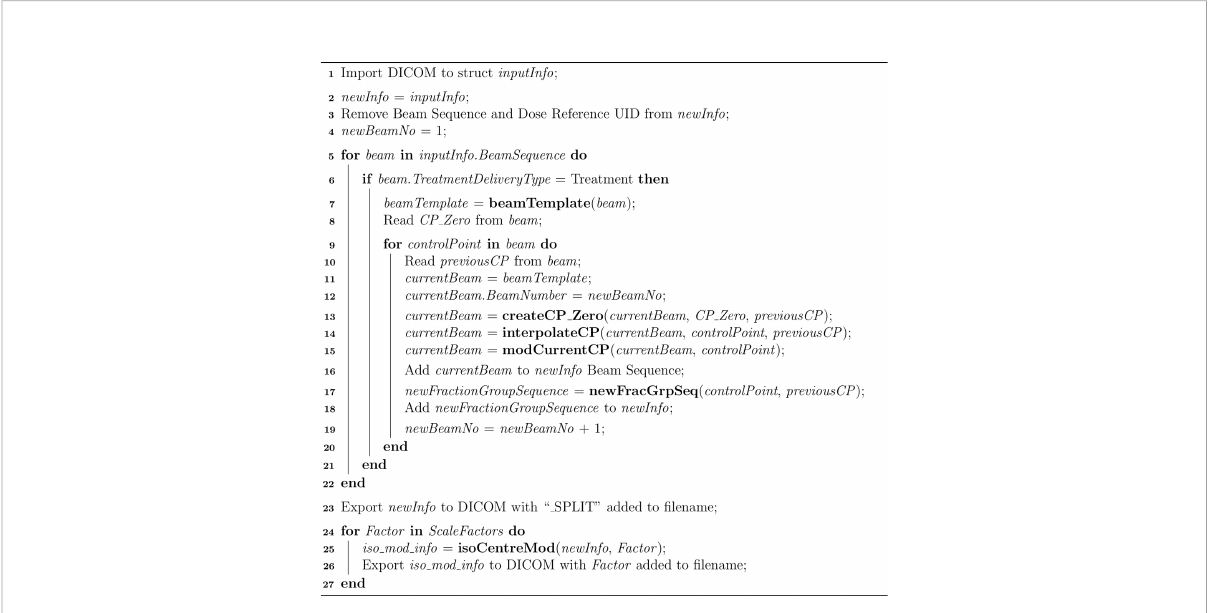
FIGURE 3 Overview of MATLAB Script Structure. Lines 1 – 4 remove plan identi fi ers and setup required objects. Lines 5 – 22 split the VMAT arcs at each CP, linearly interpolate midpoints and modify the fraction group sequence such that the overall monitor units remain the same. Line 23 exports the split plan to DICOM. Lines 24 – 27 apply varying magnitudes of isocentre shift and export the produced plans to DICOM.